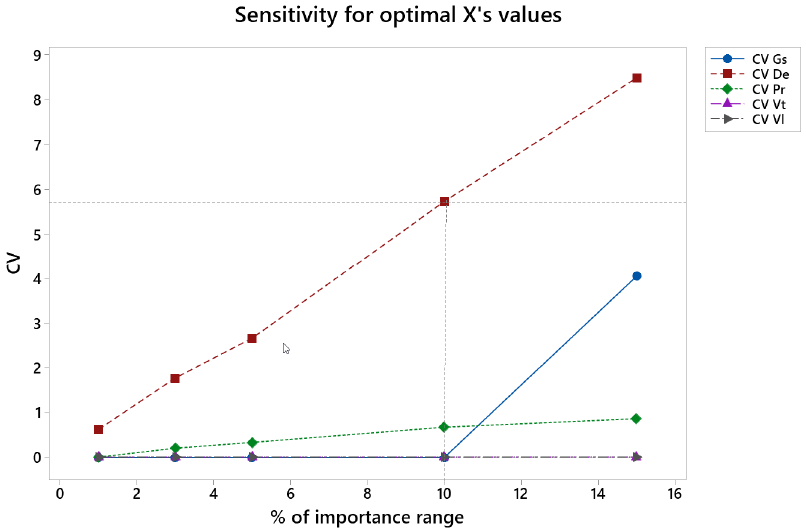
Figure 13. CV of the different factors vs. percentage of importance range in the rough honing